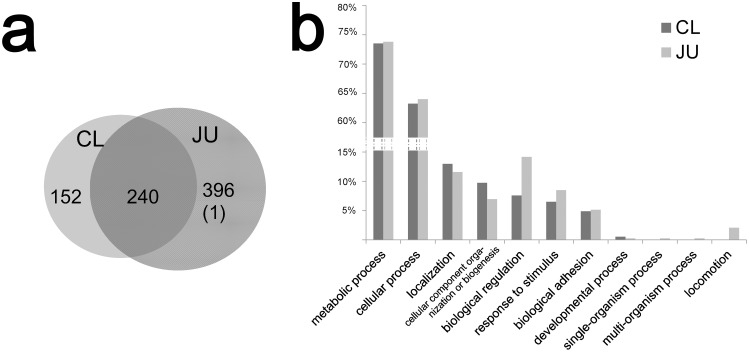
Protein identification and GO analysis.a. A Venn diagram showing the numbers of proteins identified from each sample. The number in the bracket indicates a hit from the decoy database. b. Results of GO analysis (the "biological process" category). More information of GO analysis is provided in S2 Table.